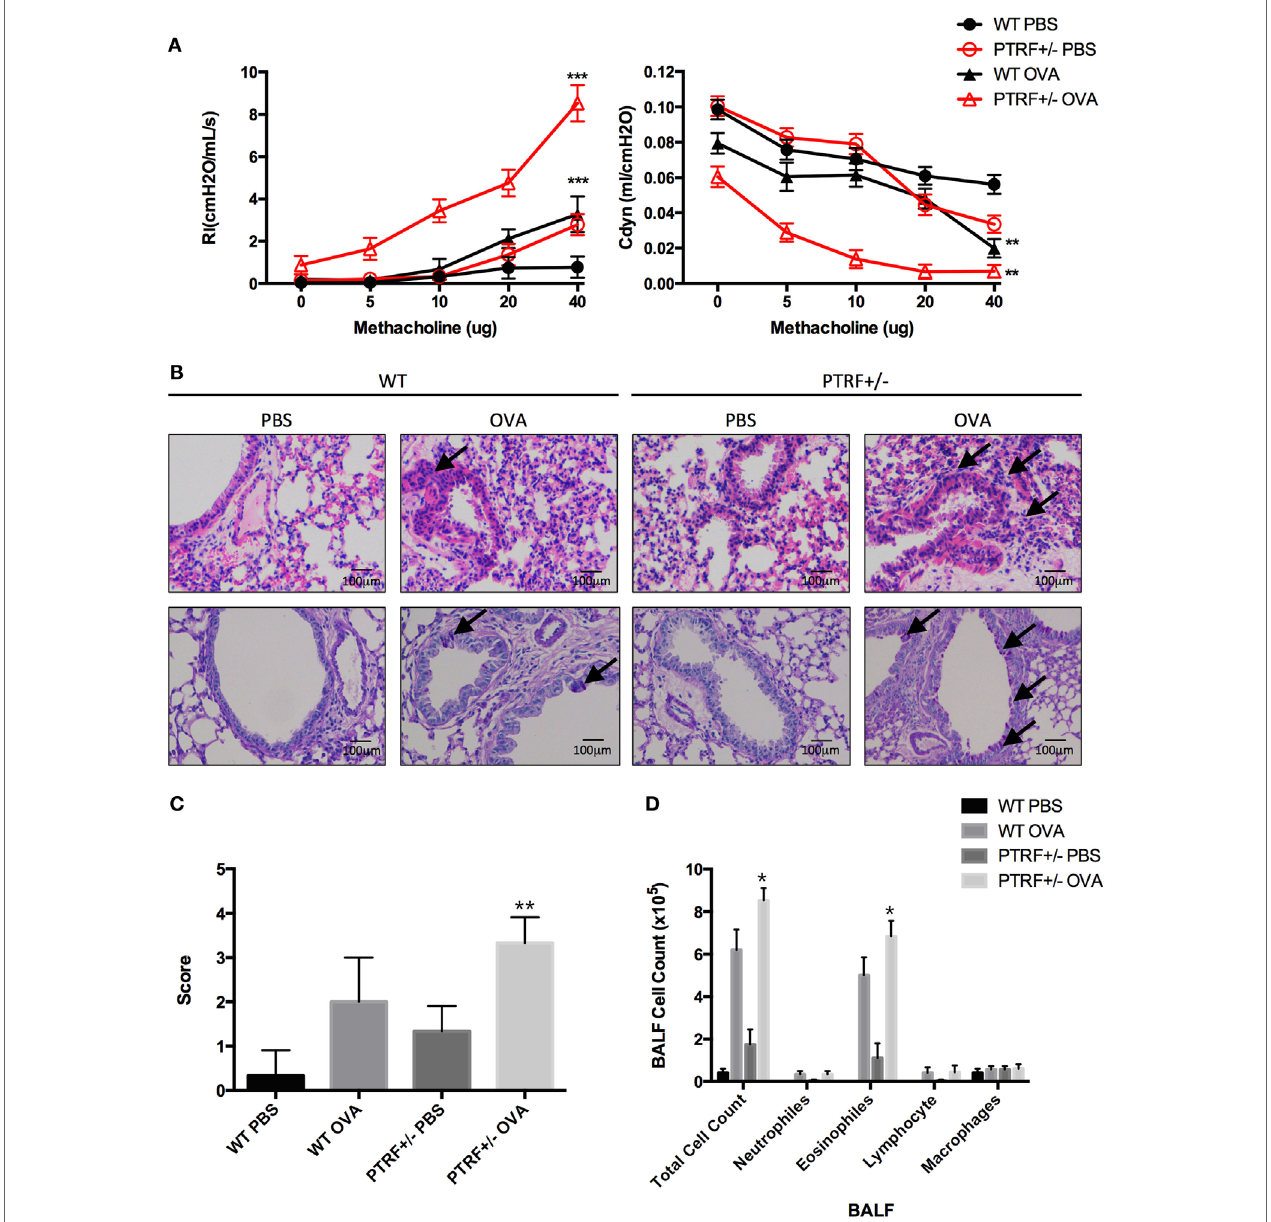
FigUre 1 | Partial loss of polymerase I and transcript release factor (PTRF) led to airway hyperresponsiveness (AHR) and eosinophilic airway inflammation. Mice were intraperitoneally injected with phosphate-buffered saline (PBS) or ovalbumin (OVA) on days 0, 7, and 14, and then challenged with PBS or OVA on days 21–27. (a) AHR in response to inhaled methacholine was measured in PBS- or OVA-challenged mice. Maximal responses to increasing doses of methacholine are shown for lung resistance (Rl) and dynamic compliance (Cdyn). (B) Representative images of hematoxylin and eosin staining of lung tissue (upper panel), and periodic acid-schiff stain (lower panel). (c) Inflammation scores of lung tissues. (D) Cell classification in bronchoalveolar lavage fluid. * p < 0.05, ** p < 0.01, *** p < 0.001. Results are pooled data from four independent experiments (mean ± SEM of n = 3–4 mice in each